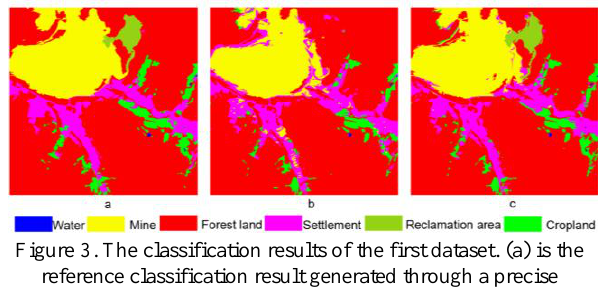
Table 2. Producer, user and overall classification accuracies